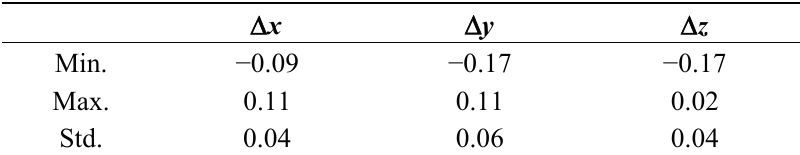
Figure 5. Differences between the estimated coordinates and reference values. Table 3. Statistical characteristics of the differences between the estimated coordinates and the reference values (unit: